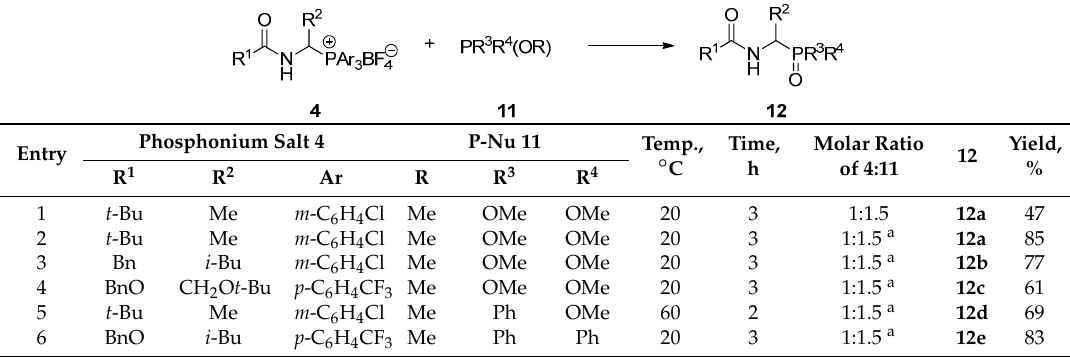
Table 4. Conditions and yields for α -amidoalkylation of P-nucleophiles by 1-( N -acylamino) alkyltriarylphosphonium salts 4 .